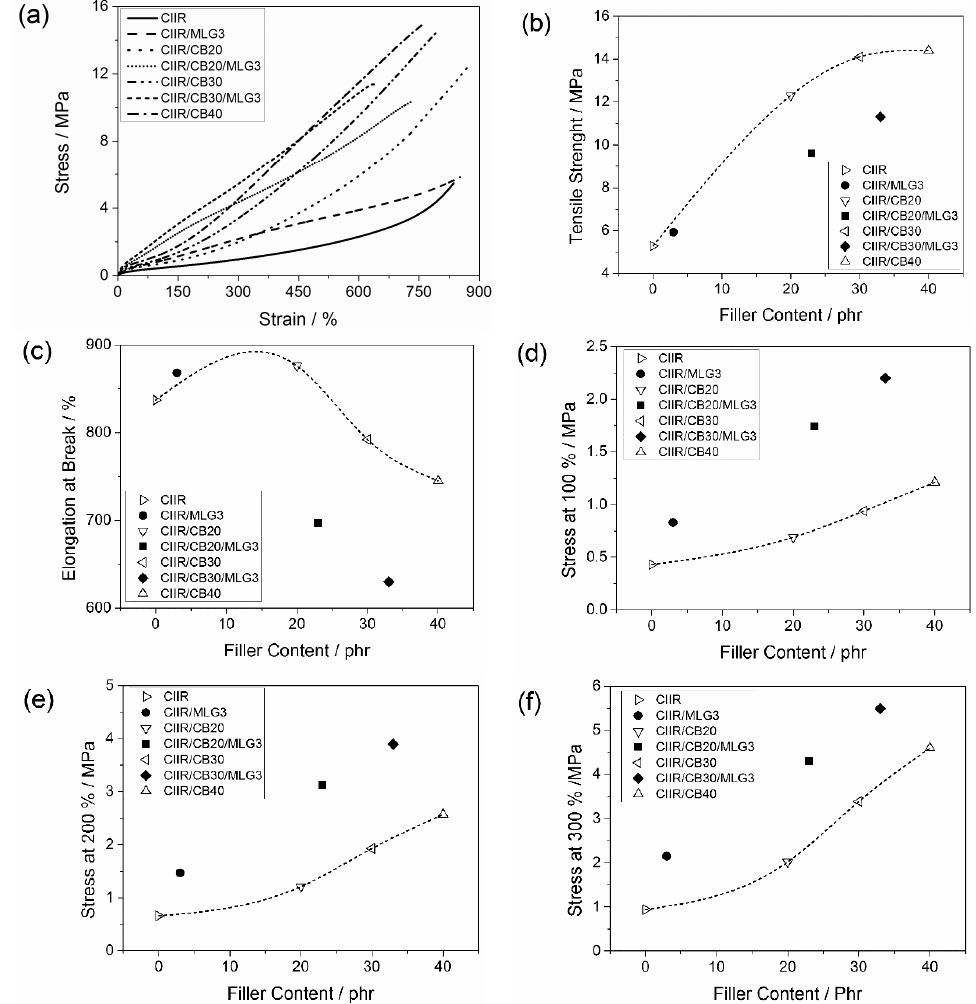
Figure 9. ( a ) Tensile stress vs. strain curves and of CIIR and its composites; ( b ) tensile strength; ( c ) elongation at break; ( d ) stress at 100% of elongation; ( e ) stress at 200% of elongation; and ( f ) stress at 300% of elongation as functions of the filler content. The lines are visual guides.